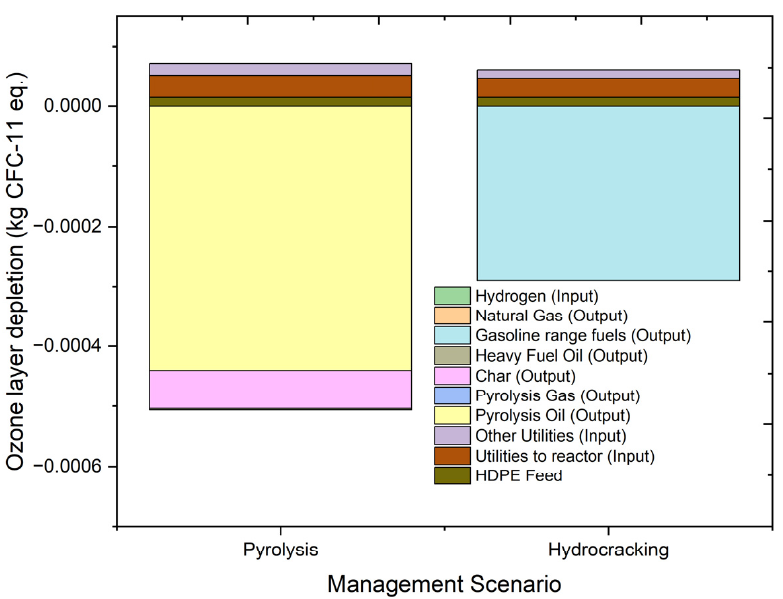
Figure 10. Impact assessment of pyrolysis and hydrocracking for the management of waste HDPE on ozone layer depletion (kg CFC-11 eq).